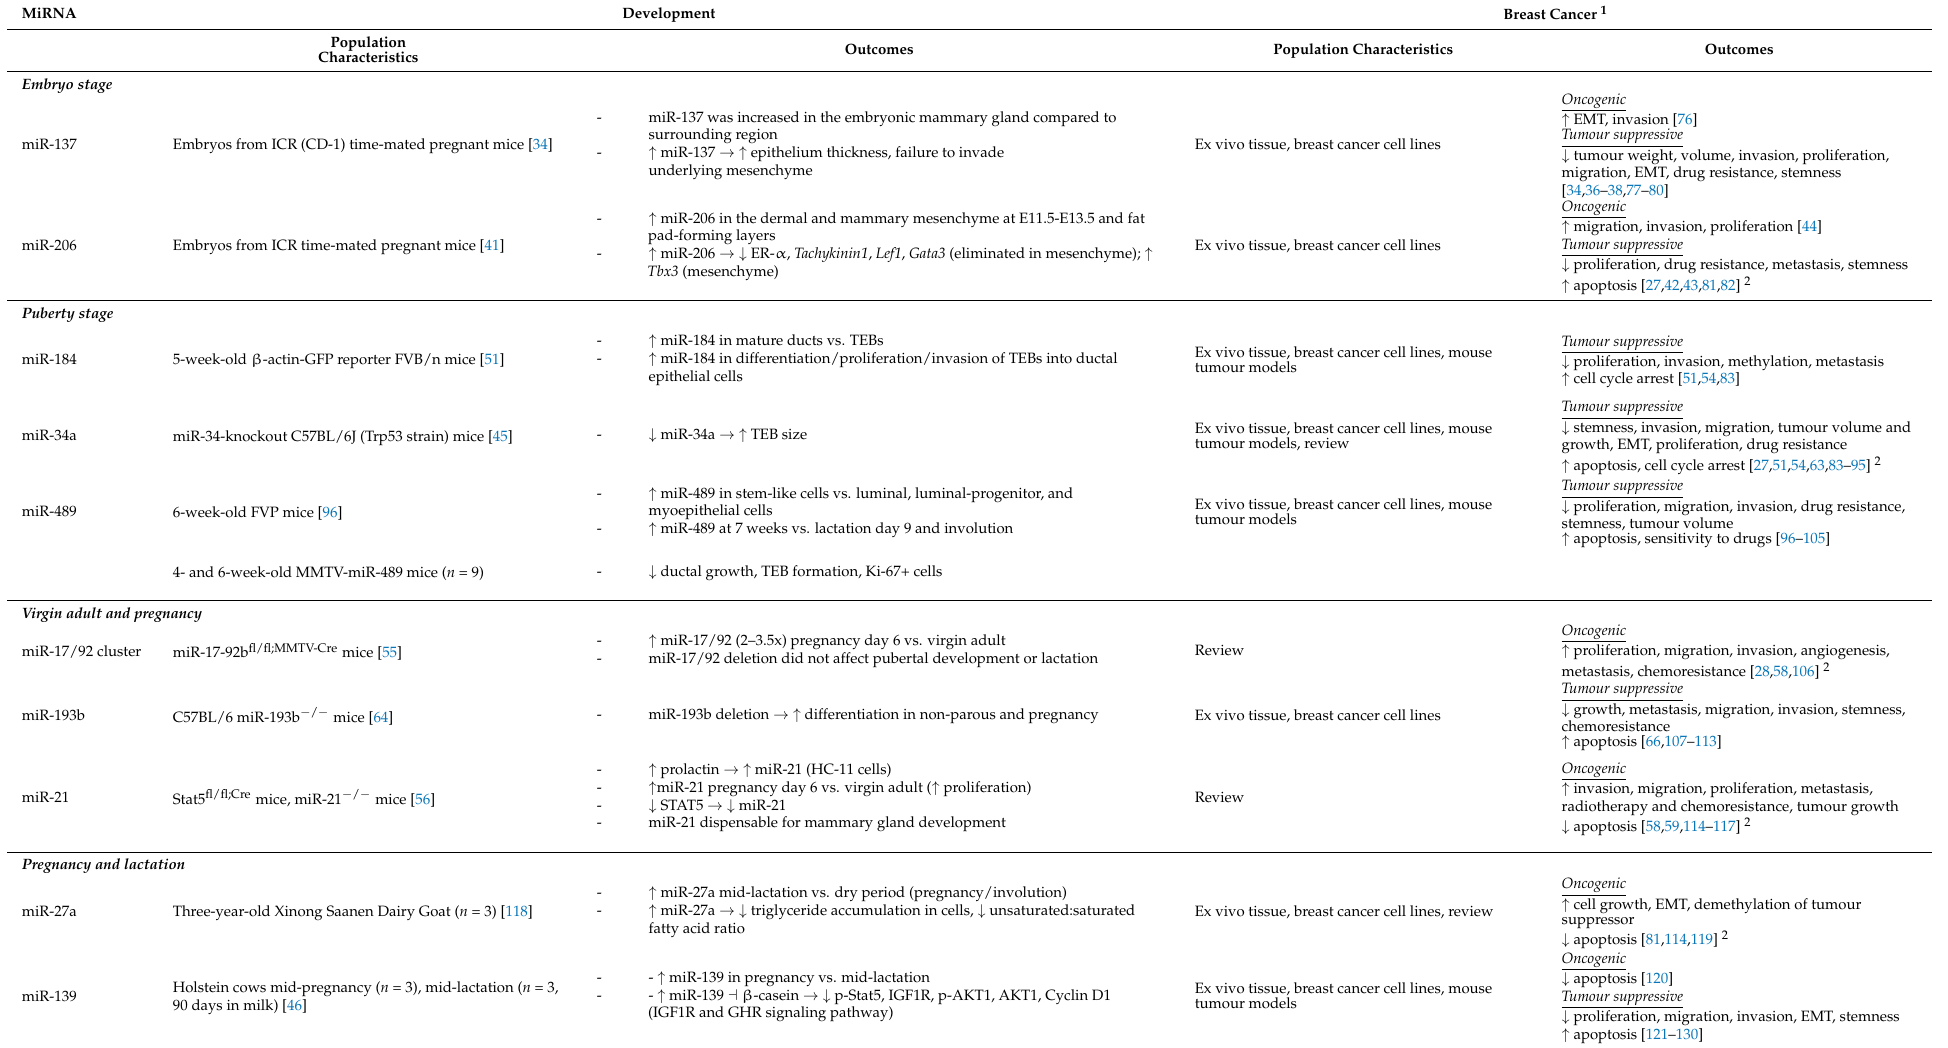
Table 1. MicroRNAs found to be involved in both mammary gland development and breast cancer.